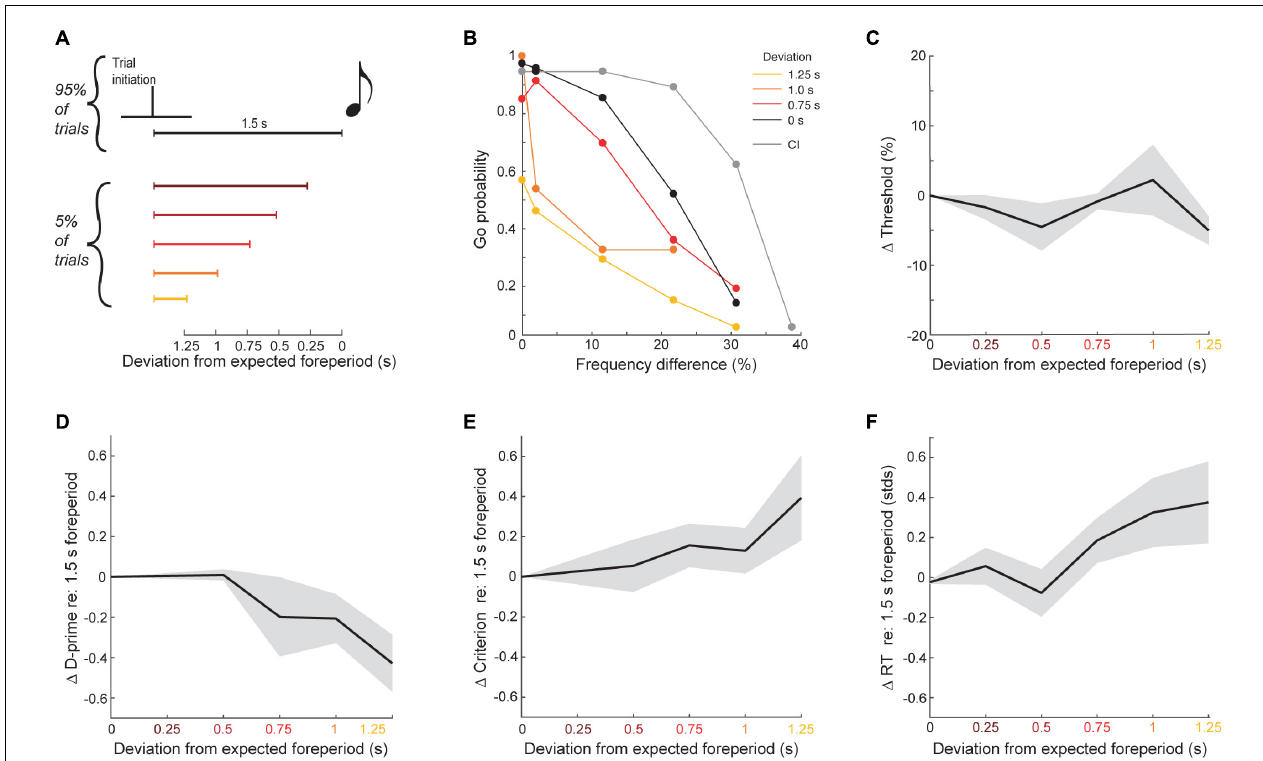
FIGURE 6 | Frequency recognition is impaired when tones occur at unexpected times. (A) Schematic of foreperiod violations. (B) Go probability as a function of frequency difference for each tested delay in one example mouse. (C) Mean ± SEM change in thresholds as a function of deviation from the expected foreperiod across all mice. (D) Change in d-prime, as in panel (C) . (E) Change in criterion, as in panel (C) . (F) Change in z-scored reaction times, as in panel (C)